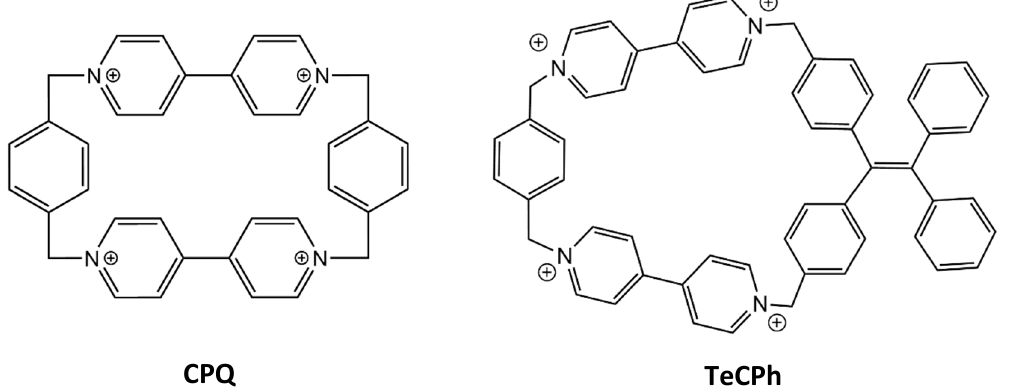
Figure 12. Structure of the cyclophane receptors CPQ [116] and TeCPh [42]. Alfonso et al. synthesized two novel oxaazamacrocycles, which presented enantiose- lective binding with both aspartate and glutamate—OA (R,R) e OA (S,S,S,S) [53]. Only